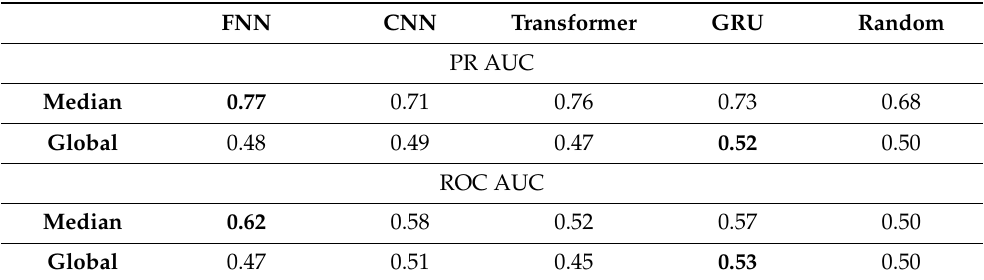
Table 8. Results for PR and ROC AUC (Global Scheme (Global) and Global scheme evaluated individually (Median)).